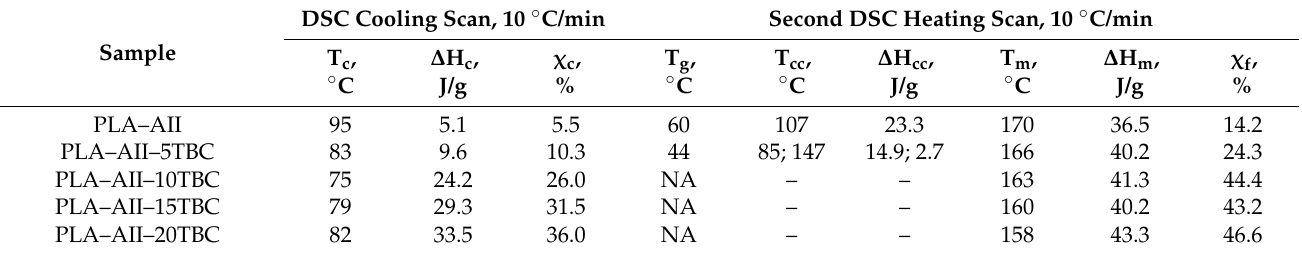
Table 3. Comparative DSC data of PLA/AII composites with/without plasticizer obtained during non–isothermal crystallization from the molten state and following the succeeding heating scan (DSC cooling and second heating by 10 ◦ C/min).